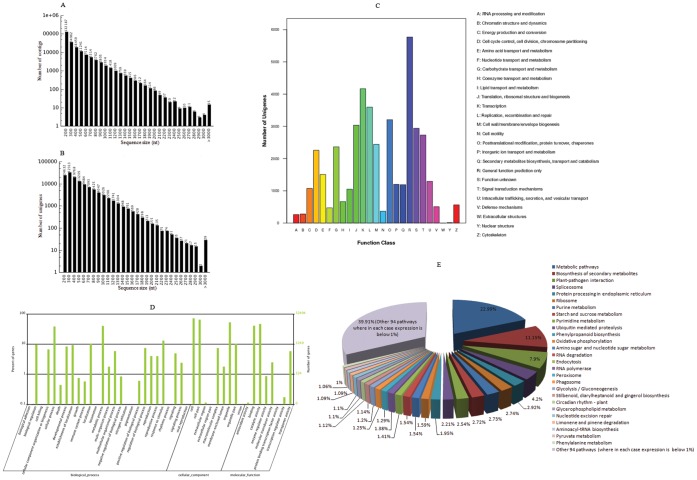
Summary of de novo transcriptome sequencing and assembly of black pepper.(A) The length distribution of contigs (B) The length distribution of Unigenes (C) Histogram showing unigene classification based on clusters of orthologous groups (COG) (D) Gene Ontology classification of unigenes (E) KEGG functional classification of unigenes.